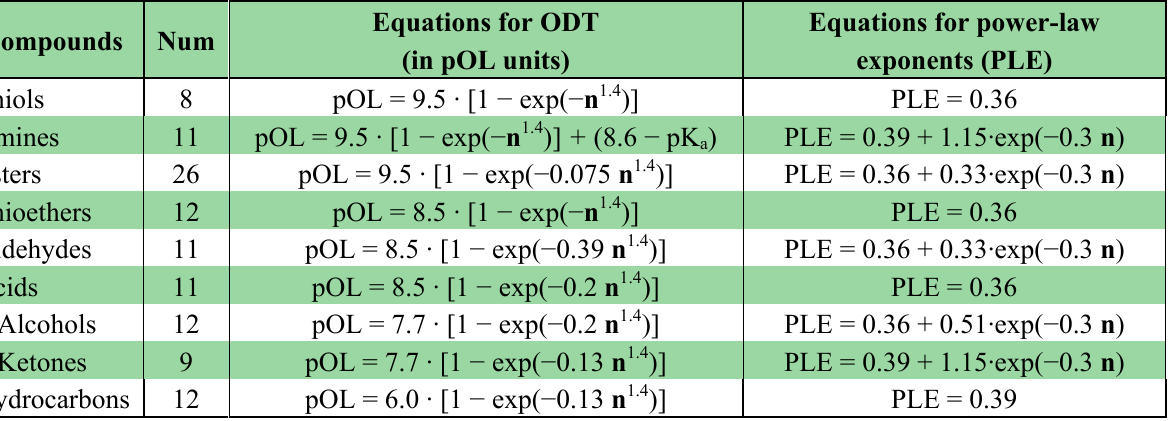
Table 1. Fitted equations for ODT (data from [16]) and power-law exponents (data from [3]) corresponding to different homologous series (“Num” stands for the number of compounds used in each ODT equation).